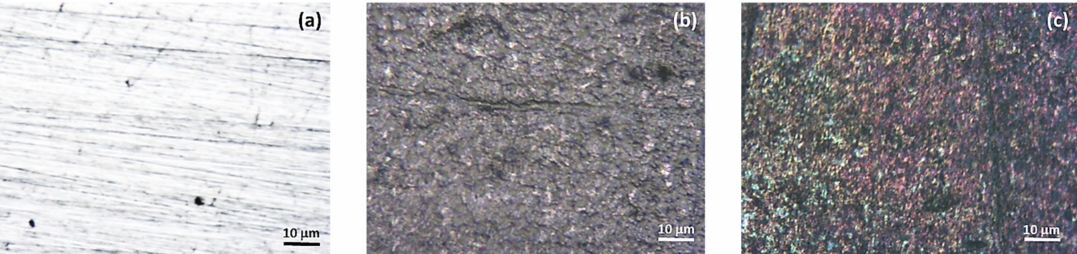
Figure 3. Optical microscopic images of ( a ) polished MS, ( b ) MS immersed in acid, and ( c ) MS dipped in 1000 ppm